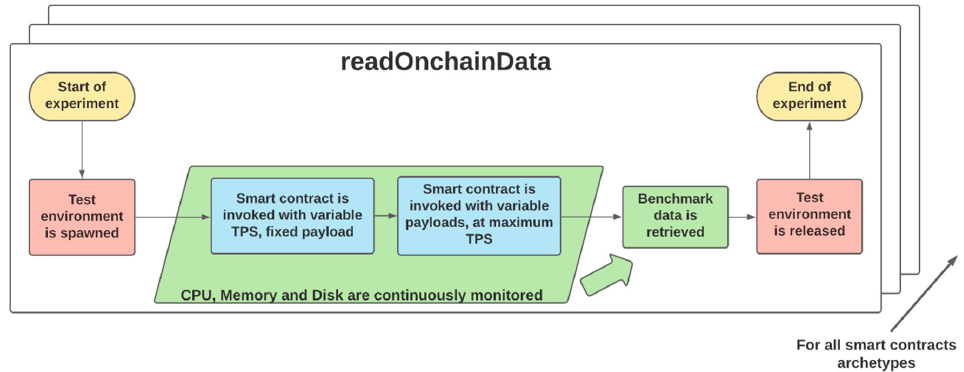
Figure 6. The procedure used during the experiments, executed for each smart contract